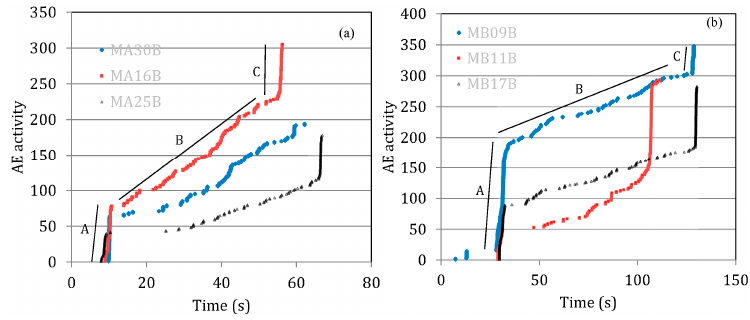
Figure 7. Cumulative AE activity history for marble type ( a ) MA and ( b ) MB.